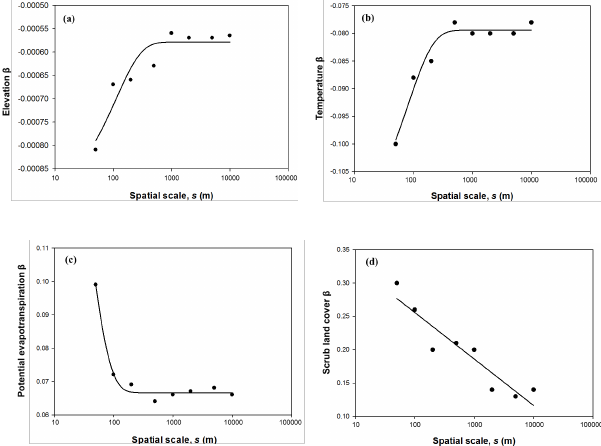
Figure 3: Figure 3. Control of environmental factors on SOC stocks as a function of spatial scale. Each dot is a median ge- ographically weighted regression coefficient ( β ) for a particular spatial scale. The fitted functions are (a) el- evation β = − 0.0009 + 0.0003 × (1 − exp( − 0.0089 × s ), adjusted temperature β = adjusted (c) potential evapotranspiration β = 0.066 + 0.187 × exp( − 0.035 × s ), adjusted R 2 = 0.97, P <0.001, (d) scrub β = 0.395 − 0.0696 × s , adjusted R 2 = 0.85, P